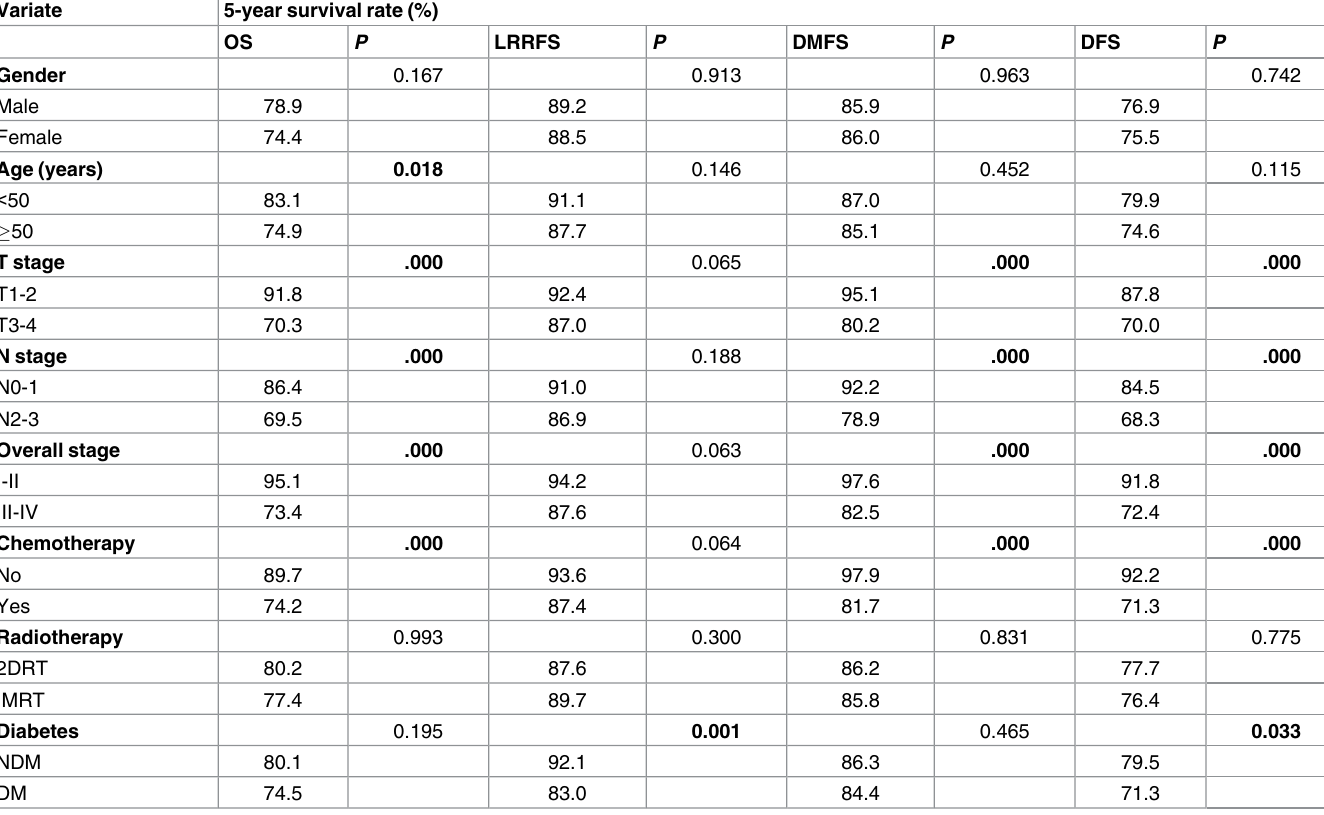
Table 4. Univariate analysis of prognostic factors for the two groups of NPC patients. Variate